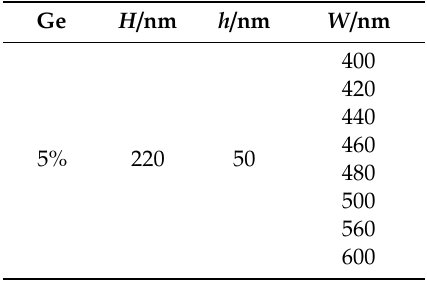
Table 1. Structure parameters of SiGe-OI waveguide and SiGe-SOI waveguide.